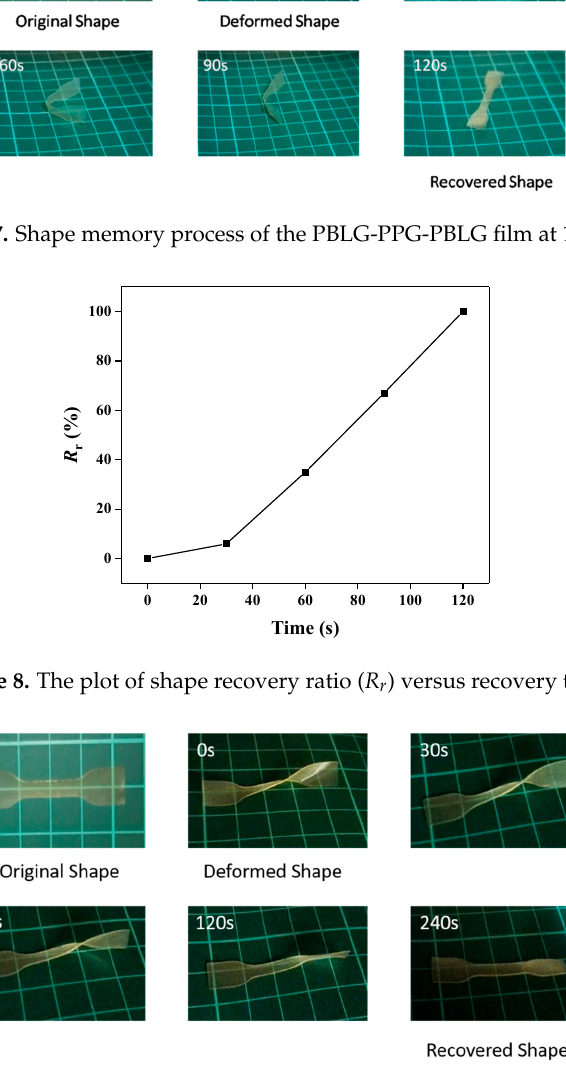
Figure 9. Recovery process of the spiral-deformed PBLG-PPG-PBLG film at 100 °C.